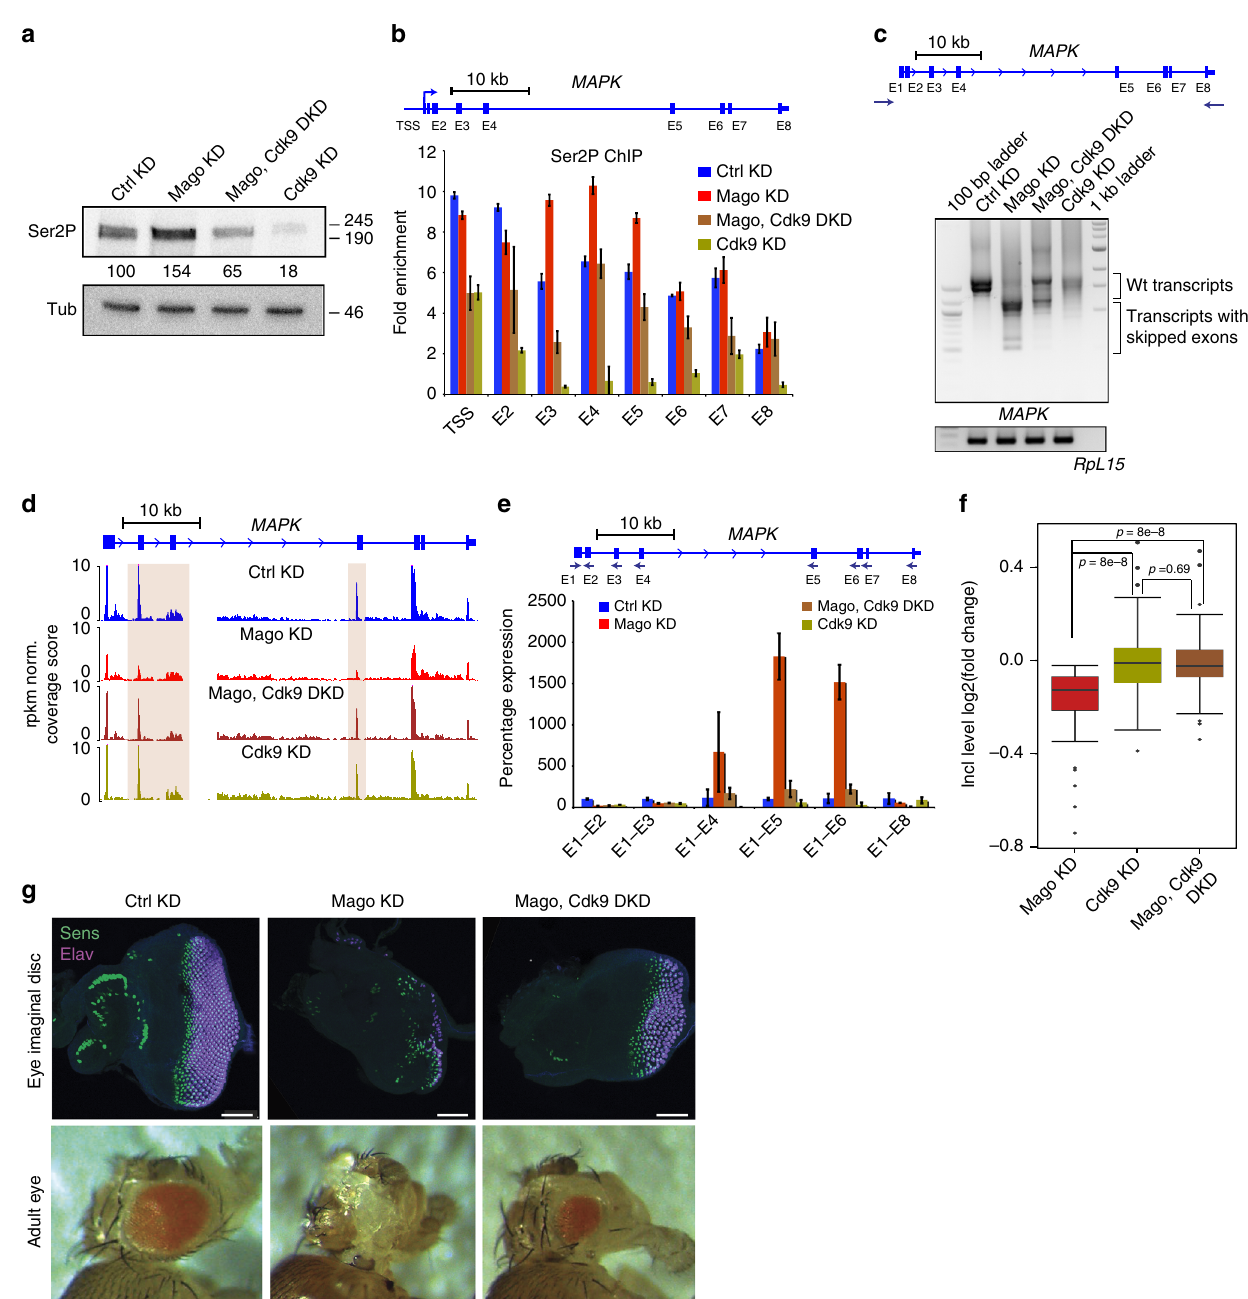
Fig. 6 Restoring pausing is suf fi cient to rescue Mago-associated exon skipping defects. a Mago knockdown results in elevated level of Ser2P phosphorylation of Pol II. Western blots using antibodies against Pol II Ser2P and Tubulin, using S2R + cell extracts with indicated knockdowns. Signal in the knockdown conditions was normalized to the control condition using Tubulin as loading control and quanti fi cation of the intensity was performed with ImageJ. b ChIP-qPCR analysis of Ser2P occupancy level at MAPK locus in the indicated knockdowns. The primers used for the analysis are indicated in the scheme above. Bars indicate the 95% con fi dence interval from the mean of two biological replicates. c Agarose gels showing RT-PCR products for MAPK and RpL15 using RNA extracted from S2R + cells with indicated knockdowns as template for cDNA synthesis. The primers used for the PCR 5 ʹ and 3 ʹ UTR of MAPK are shown in the scheme above. RT-PCR products for RpL15 from respective knockdown condition were used as loading control. d Replicate averaged RNA-Seq track examples of MAPK in several knockdown conditions. Mago KD results in several exon skipping events, which are rescued upon simultaneous knockdown of Cdk9. The exons skipped in Mago knockdown condition are highlighted by colored rectangles e Quantitative RT-PCR using RNA extracts derived from S2R + cells with the indicated knockdowns. The amplicons were obtained using the same 5 ʹ forward primer (E1) together with the reverse primers on respective exons, as shown in the scheme above. The level of exon skipping is compared to the control treatment, with RpL49 used for normalization. Bars indicate the 95% con fi dence interval from the mean of two biological replicates. f Box plots showing the log2 fold change in inclusion level of alternatively spliced exons in the indicated knockdowns (rMATS was used for the analysis). g Upper panel: Staining of eye imaginal discs from third instar larvae with indicated dsRNAs speci fi cally expressed in the eye (using the ey -GAL4 driver). All photoreceptors are stained with anti-Elav antibody (purple), and R8 (the fi rst class of photoreceptor to be speci fi ed) with anti-Senseless (green). Scale bar 50 μ M. Lower panel: Adult eyes of a control fl y and fl ies with indicated